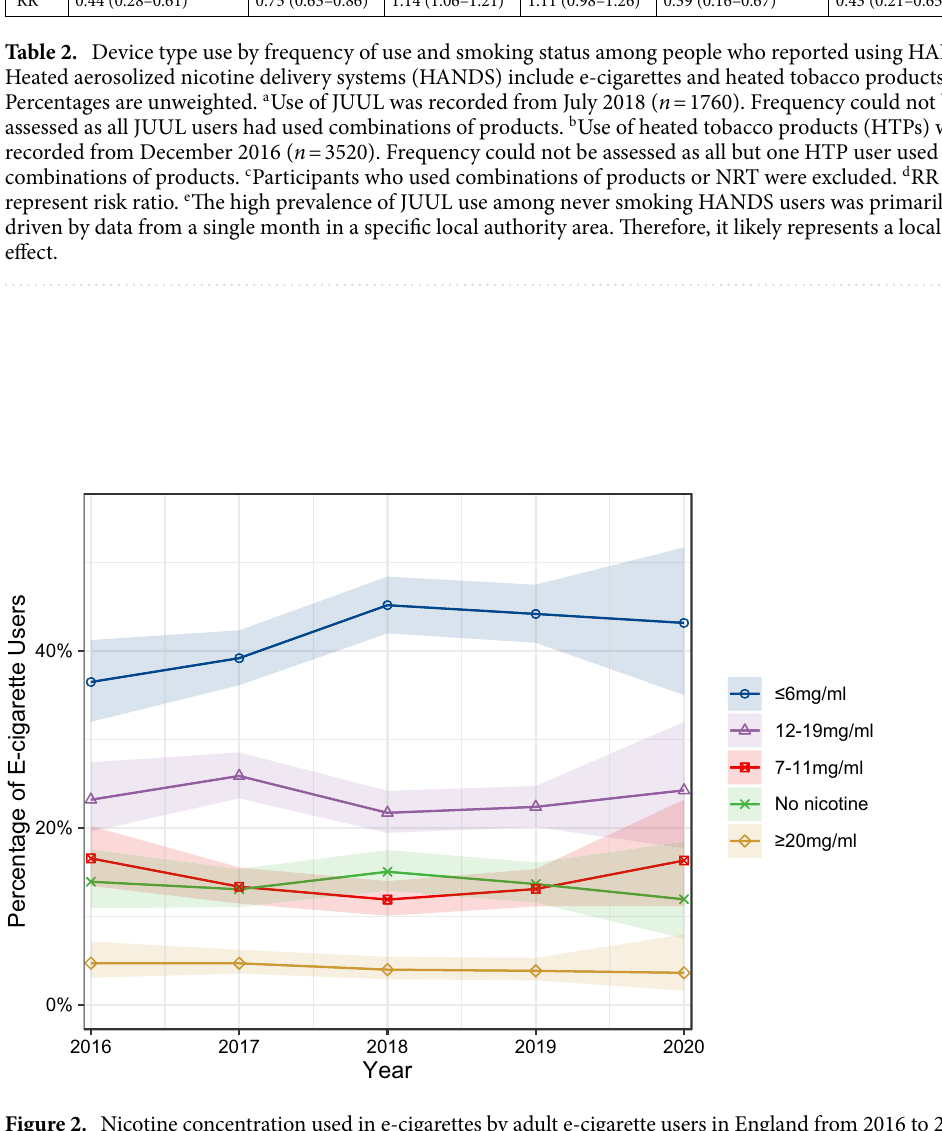
Figure 2. Nicotine concentration used in e-cigarettes by adult e-cigarette users in England from 2016 to 2020. Shaded bands represent 95% CrIs. Trends would be the same with a denominator of all adults rather than only e-cigarette users, as overall prevalence of e-cigarette use was stable from 2016 to 2020 (Supplementary Fig.